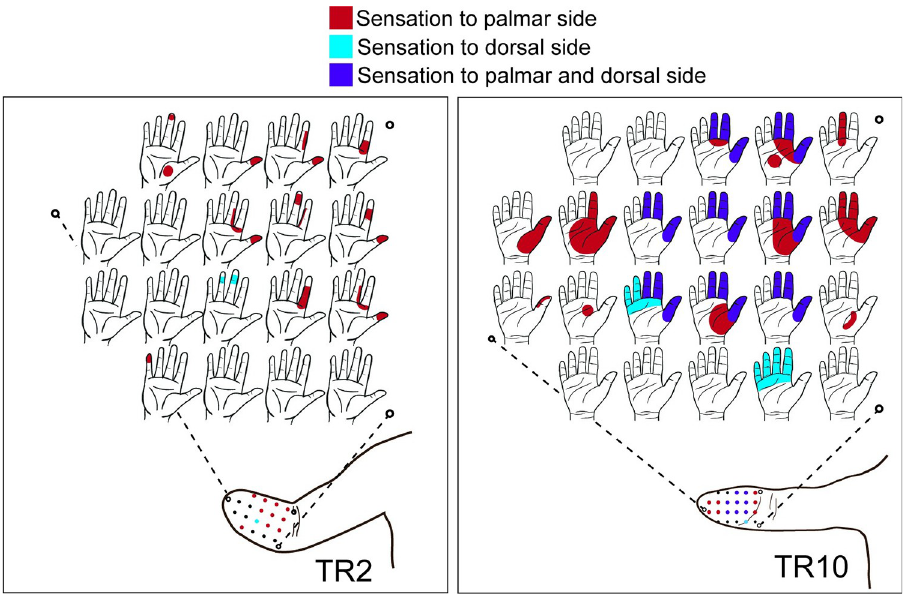
Fig 5. Reinnervated forearm skin of the two subjects who underwent targeted sensory reinnervation. For both individuals, sensations referred from their missing hand were felt in their residual forearm. Referred sensations were localized to either the palmar side (red), the dorsal side (blue), or both